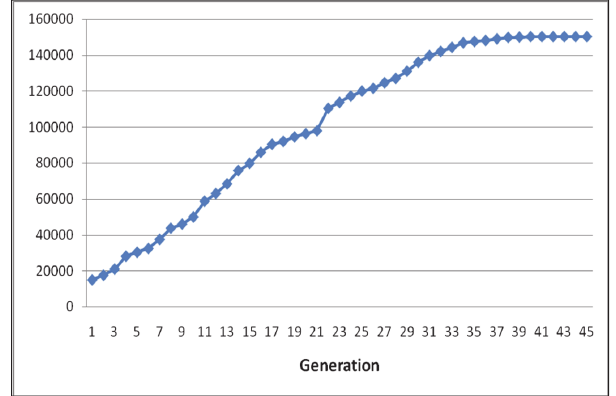
Fig. 2.Improvement of objective function over generations